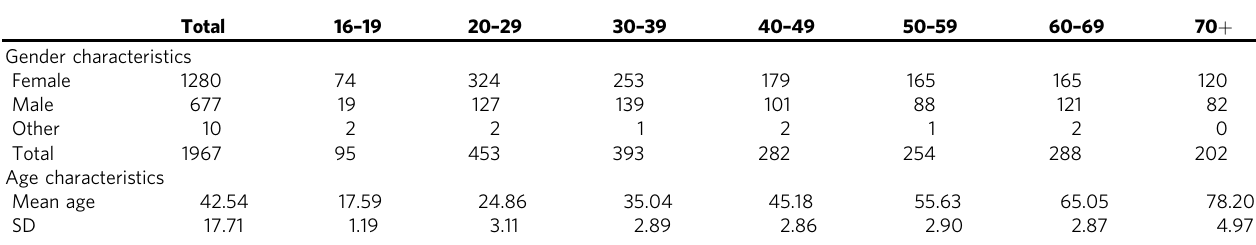
Table 1 Age and gender characteristics for individual age cohorts of the participant